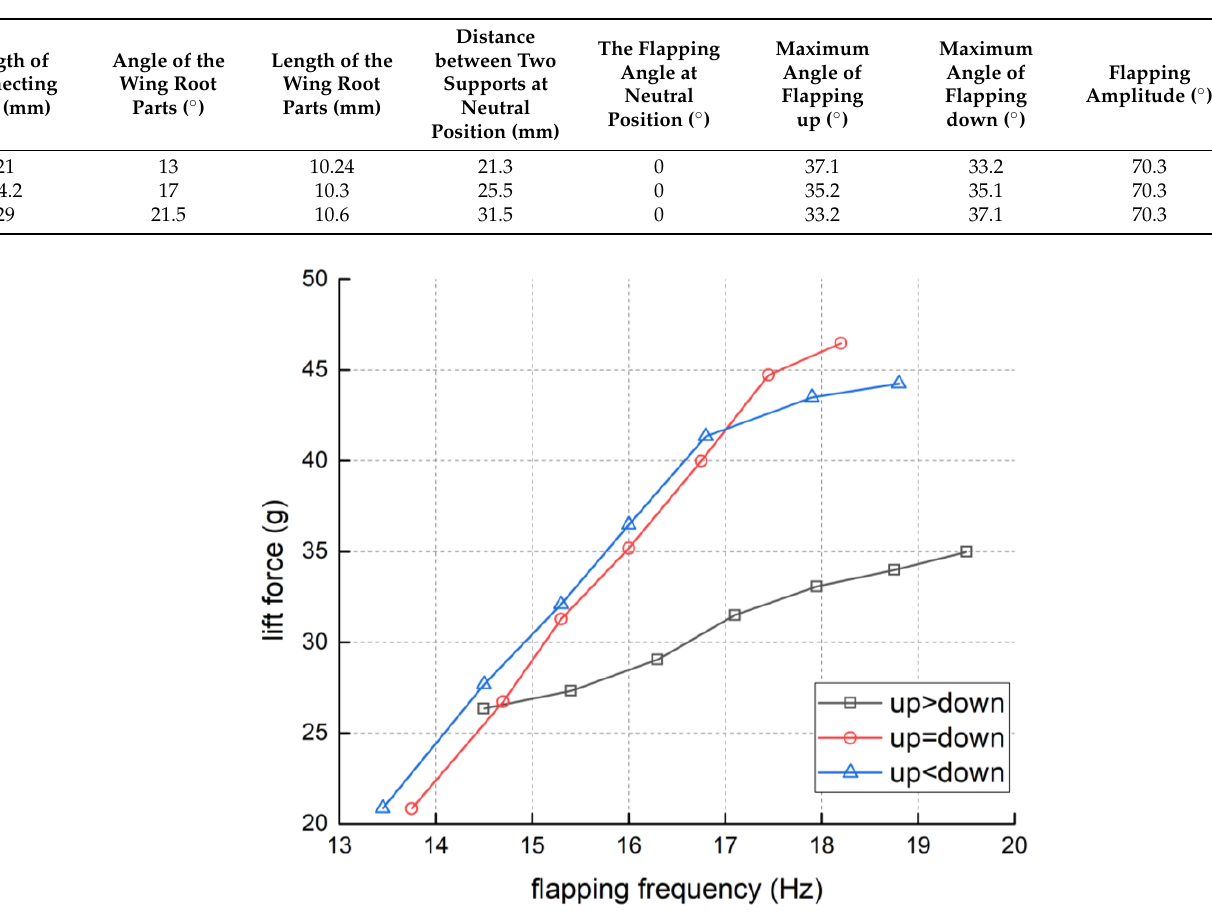
Figure 20. The flapping frequency-lift force line chart of the FWR with different maximum angles of flapping up and down.